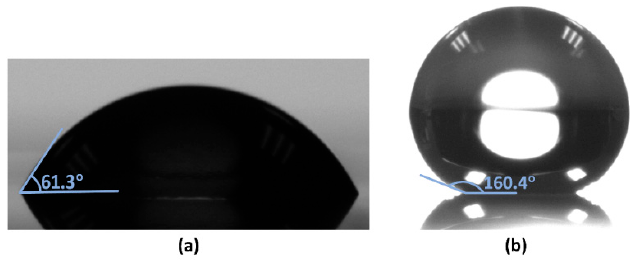
Figure 4. DI water droplet on the mixture film ( a ) untreated and ( b ) fluorinated by RIE.